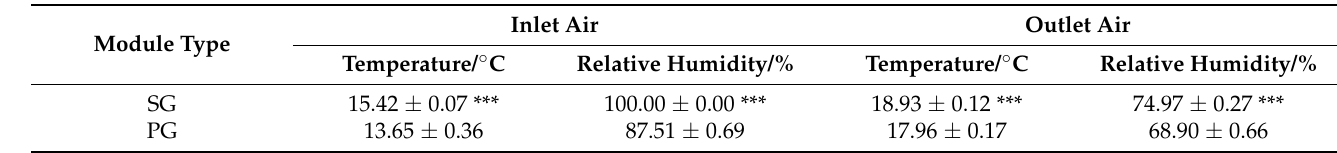
Table 5. SPSS significance test of the average air temperature and humidity of the air inlet and outlet on a typical cloudy day.